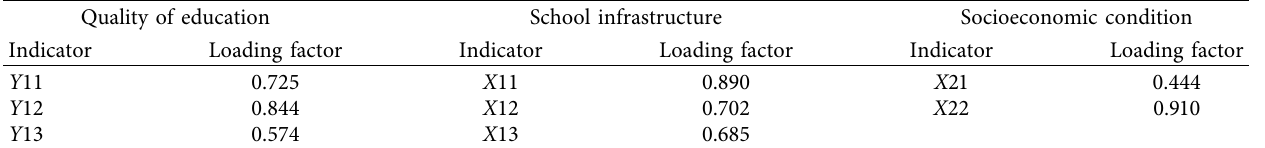
Table 3: The value of the loading